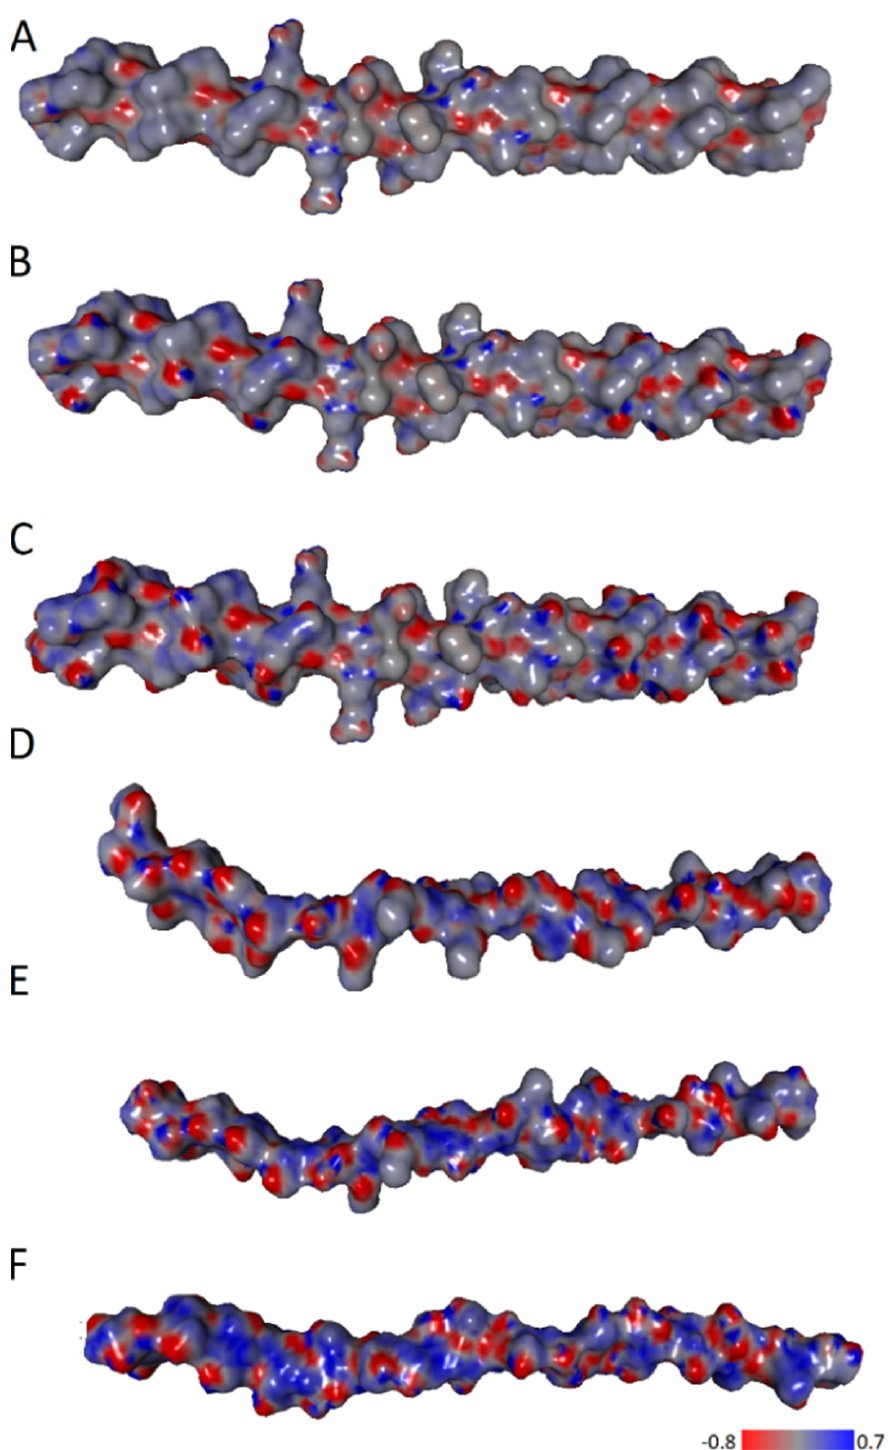
Figure 7. ESP for ( A ) Collagen HD = 0, ( B ) Collagen HD = 0.43, ( C ) Collagen HD = 1, ( D ) chitosan DD = 0.125, ( E ) chitosan DD = 0.5, ( F ) chitosan DD = 1.